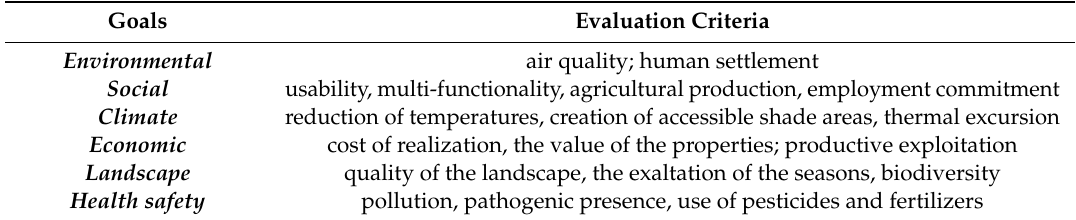
Table 2. The objectives and evaluation criteria adopted in the applied model for the urban green areas of Catania.